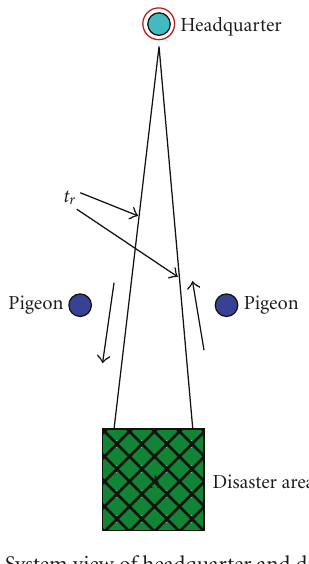
Figure 1: System view of headquarter and disaster